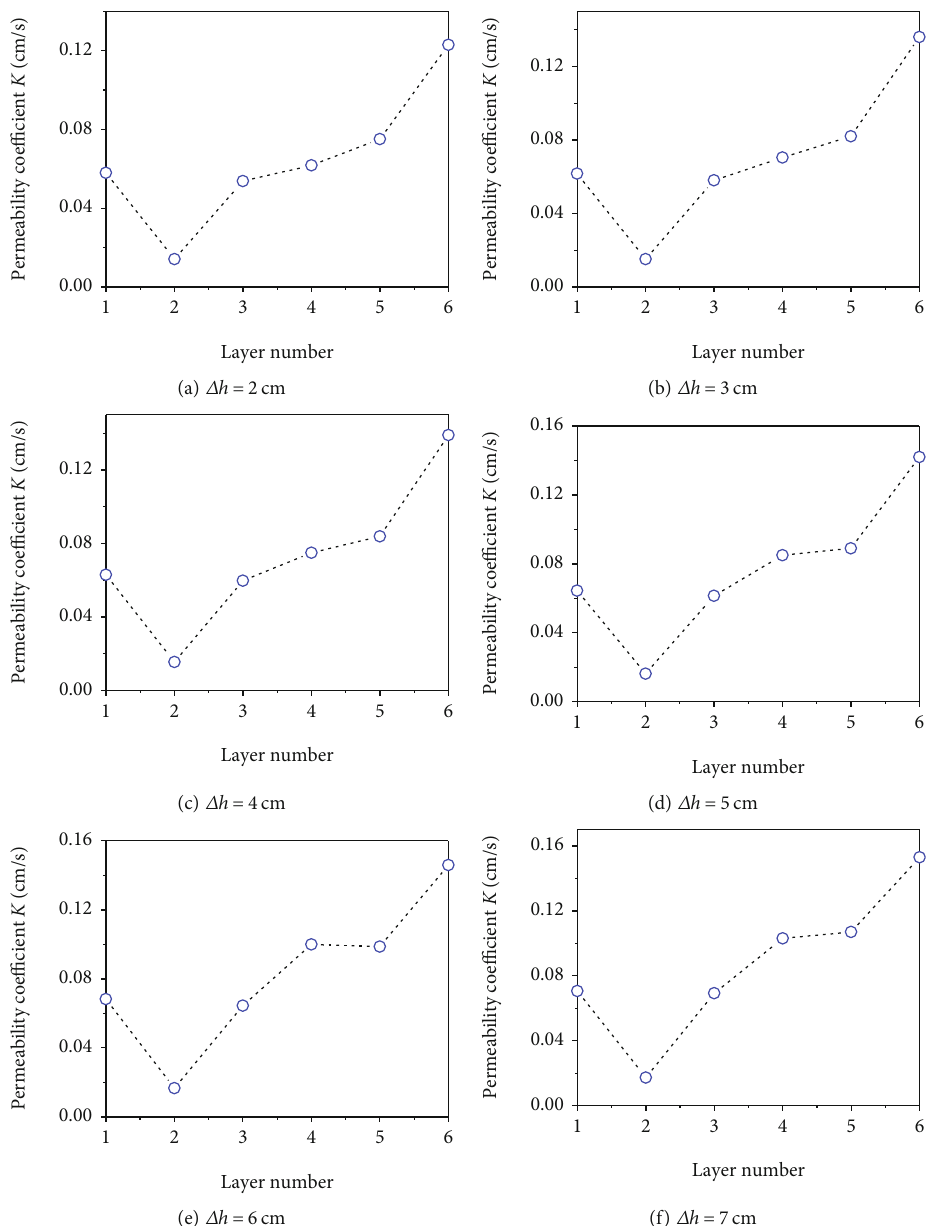
Figure 18: Variation of the permeability coe ffi cient of the slotted tube overlay multilayer